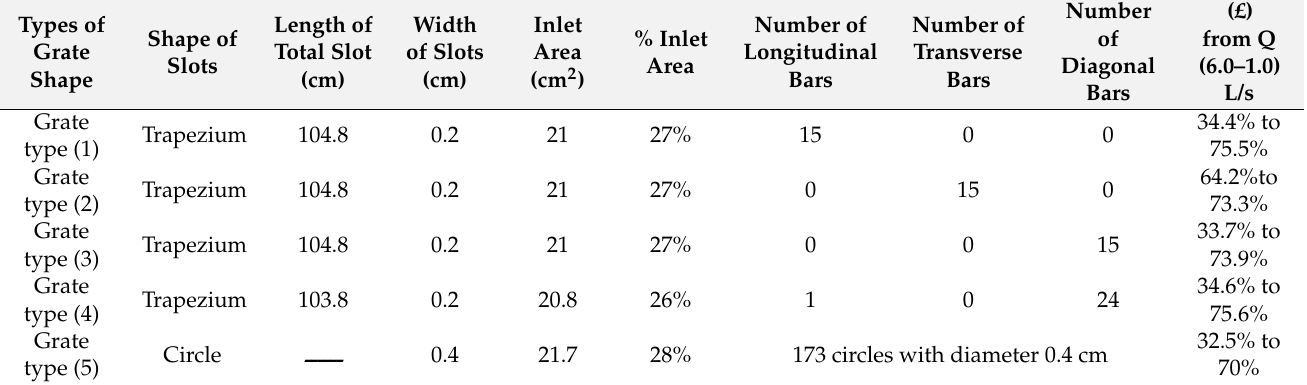
28% 173 circles with diameter 0.4 cm